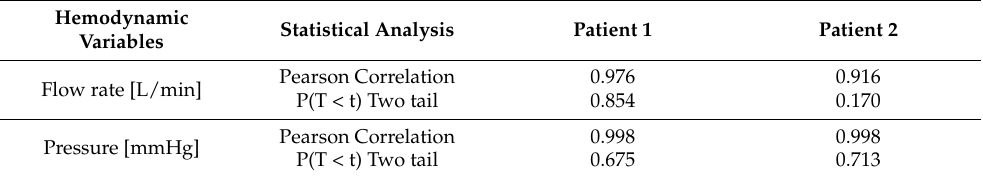
Table 10. Statistical analysis using paired t-test between catheter report and in-vitro measurements on cycle averaged flow rate and pressure findings for patient-1 and patient-2.